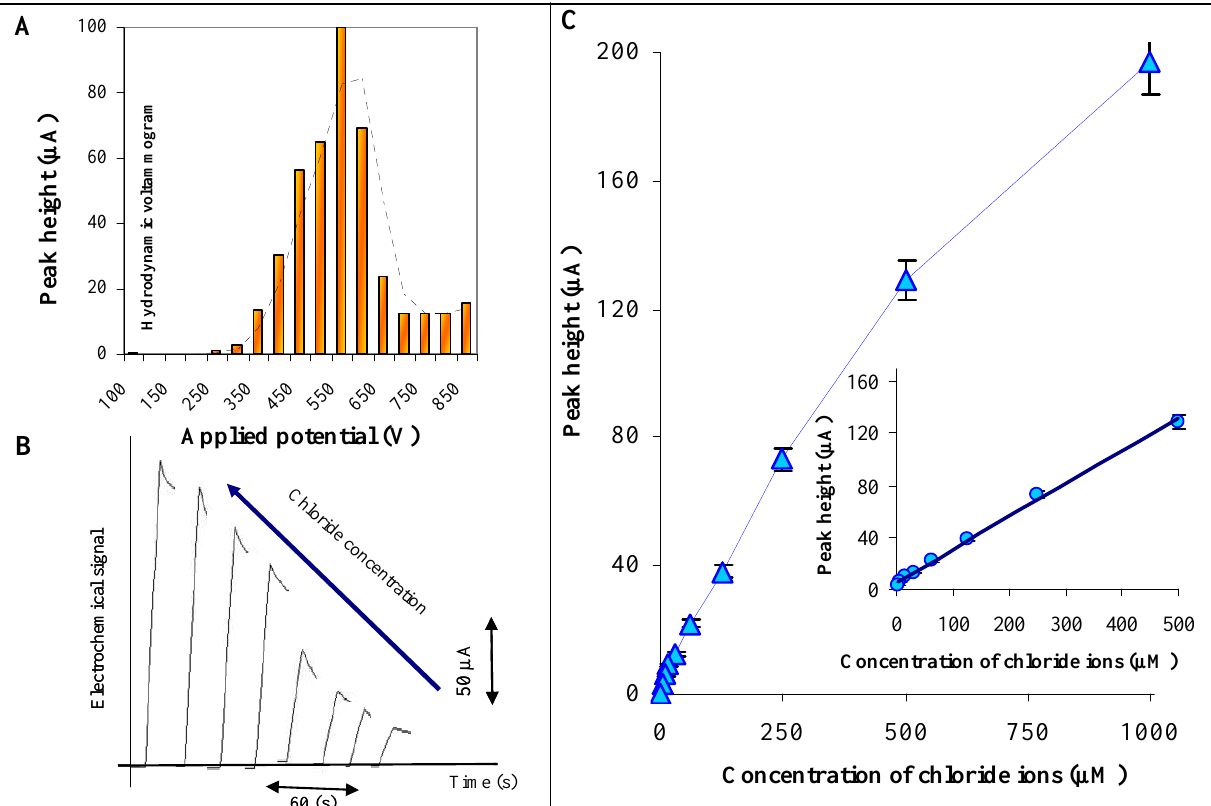
Figure 7. Chloride ion detection using screen printed electrodes. ( A ) Hydrodynamic voltammogram of chloride ions (100 µM). ( B ) Amperometric signals of chloride ions (1000, 500, 250, 125, 63, 32, 15 and 7 µM). ( C ) Calibration